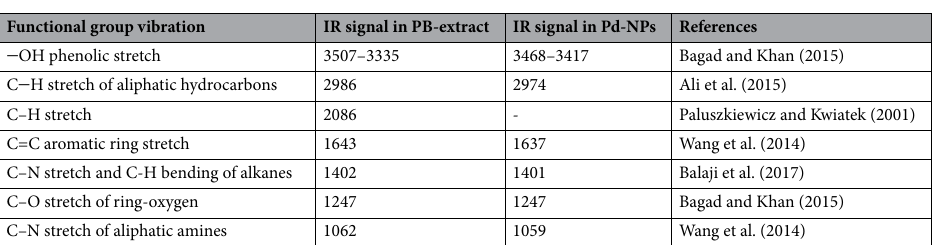
Table 1. FT-IR investigation of functional group signals and bond